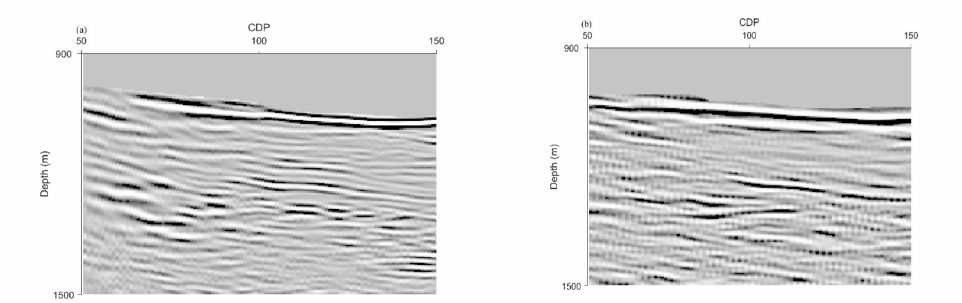
Figure 6. Details of the blue dashed box (in Figure 5) using different kinds of waves: ( a ) primary wave; and ( b ) multiple